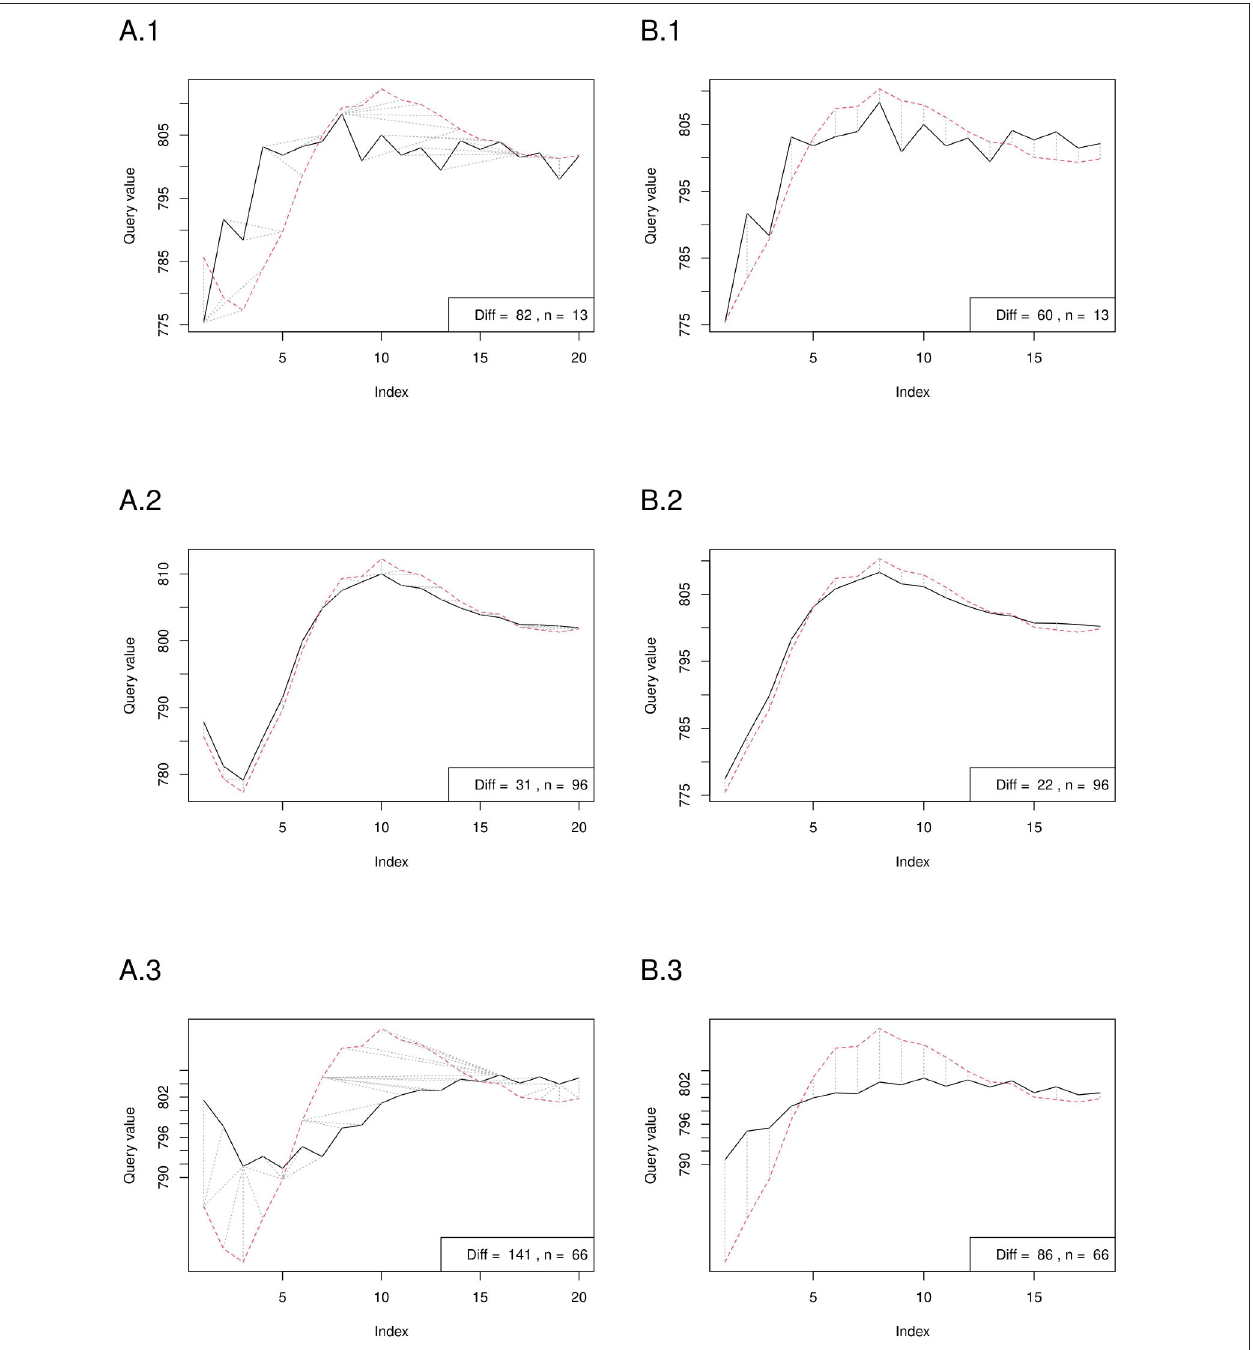
FIGURE 6 | Dynamic time warping (DTW) analysis of exemplary postRRs grouped by their respective TT. The left side (A) shows the analysis of the stVPCS with the full postRRs sequences, the right side (B) with the cut sequences. From up to down the plots show the comparisons for TT 1 (1), 3 (2), and 7 (3). The full averaged sequence of TT 1 (A.1) lacks the initial bend and shows an immediate IL incline. The sequence of TT = 3 fits the stVPCS the best, both in the full (A.2) and in the cut version (B.2) . for risk assessment but also as part of diagnostics. Possibly, DTW could replace the original HRT parameters, because it analyzes the tachogram as a whole instead of reducing it to selective parameters that can be biased as seen in this study with